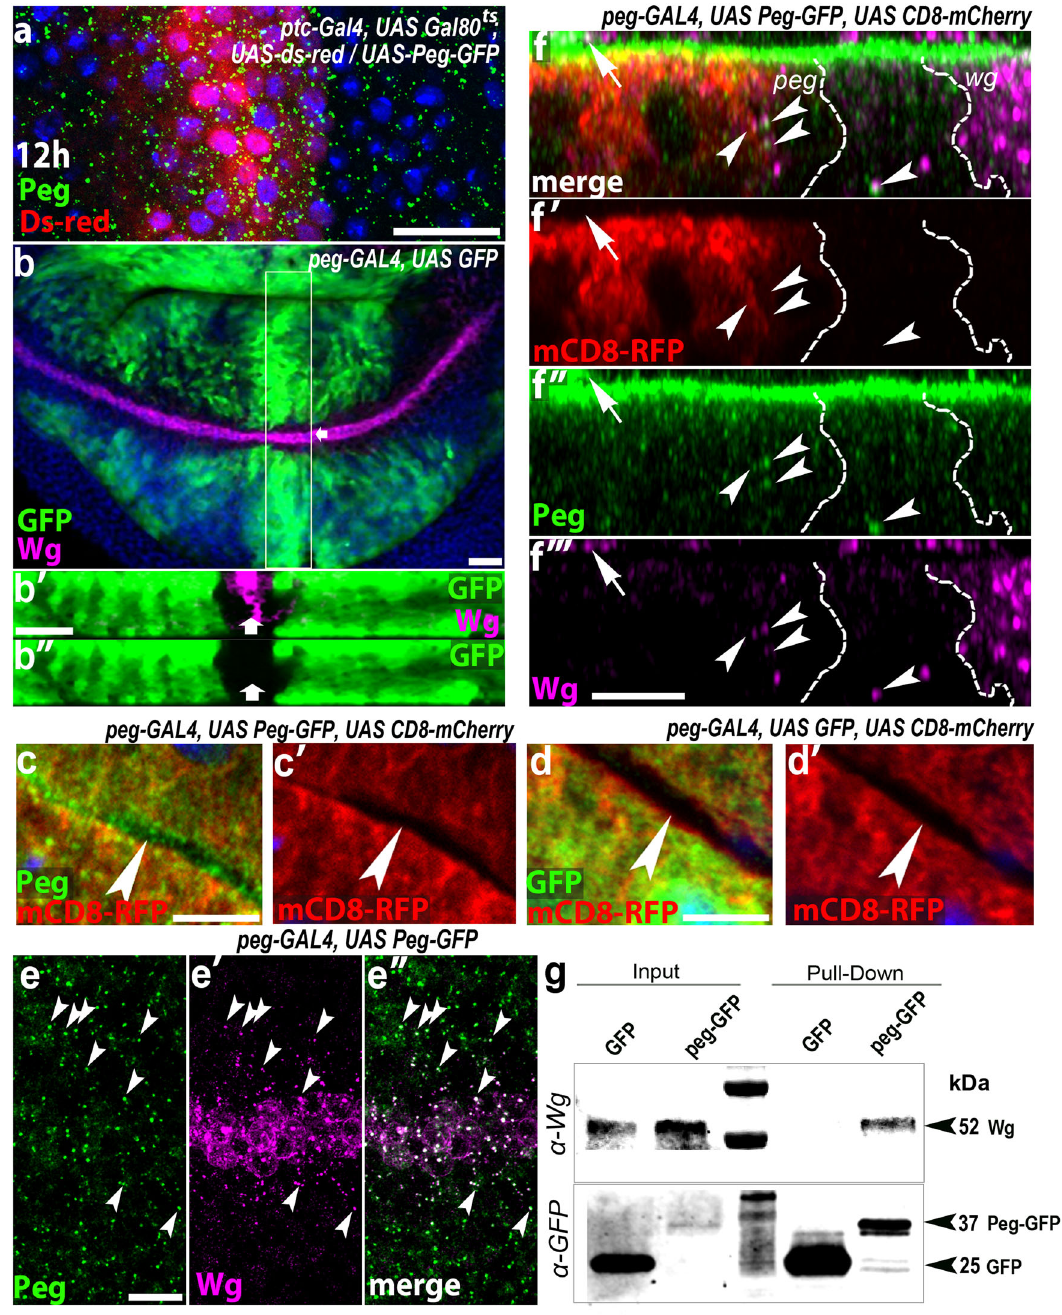
Fig. 3 Peg is secreted and interacts with Wg. a PegGFP (green dots) is found outside and beyond the cells expressing it (labelled with dsRed) after 12h of induction with ptcGal4-UASGal80 ts (methods). b peg-Gal4 (methods, Fig. S9) reconstitutes the peg gene expression pattern in the wing pouch (see Fig.1c´,d´)), which does not overlap with wg gene expression as corroborated by Z-axis orthogonal reconstruction (b-b´). c , d PegGFP (green) accumulates in the extracellular space between mCD8-RFP-labelled cells (c-c´), whereas only GFP remains within the cells (red) (d-d´). e . PegGFP (green), expressed with peg-Gal4 , co-localizes with Wg (magenta) in the developing wing margin cells (white dots, arrowheads). f An orthogonal Z-axis reconstruction shows that PegGFP (green) and endogenous Wg (magenta) colocalize basolaterally (arrowheads) within and outside of their expression domains, indicated by white dashes, and revealed by strong intracellular Wg, and peg-Gal4 driven UAS-mCD8-RFP (peg). Notice that this co-localisation also takes place extracellularly on apical cell surfaces (arrow). g Pull-down with anti-GFP beads from wing discs expressing peg-GAl4 , UAS-PegGFP yields a 50 – kDa Wg-speci fi c band revealed with α -Wg (top). GFP-only negative controls show no Wg signal. Both GFP and pegGFP were similarly bound by the pull-down beads (bottom). Source data are provided as a Source Data fi le. Scale bars: a : 20 µ m; b: 30 µ m; c , d , f : 5 µ m; e : 10 µ